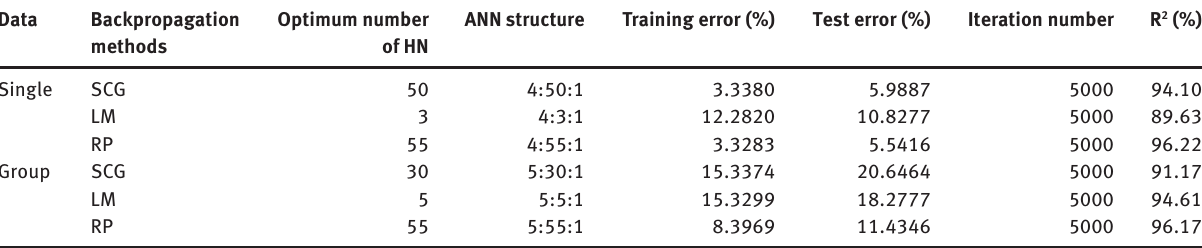
Table 4 Performance of backpropagation methods for tensile strength of adhesive anchors.